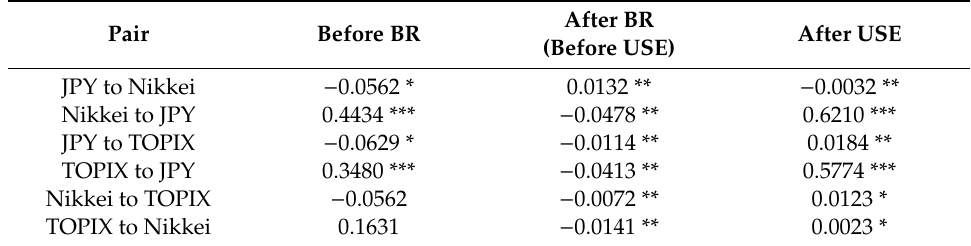
Table 4. Causality in